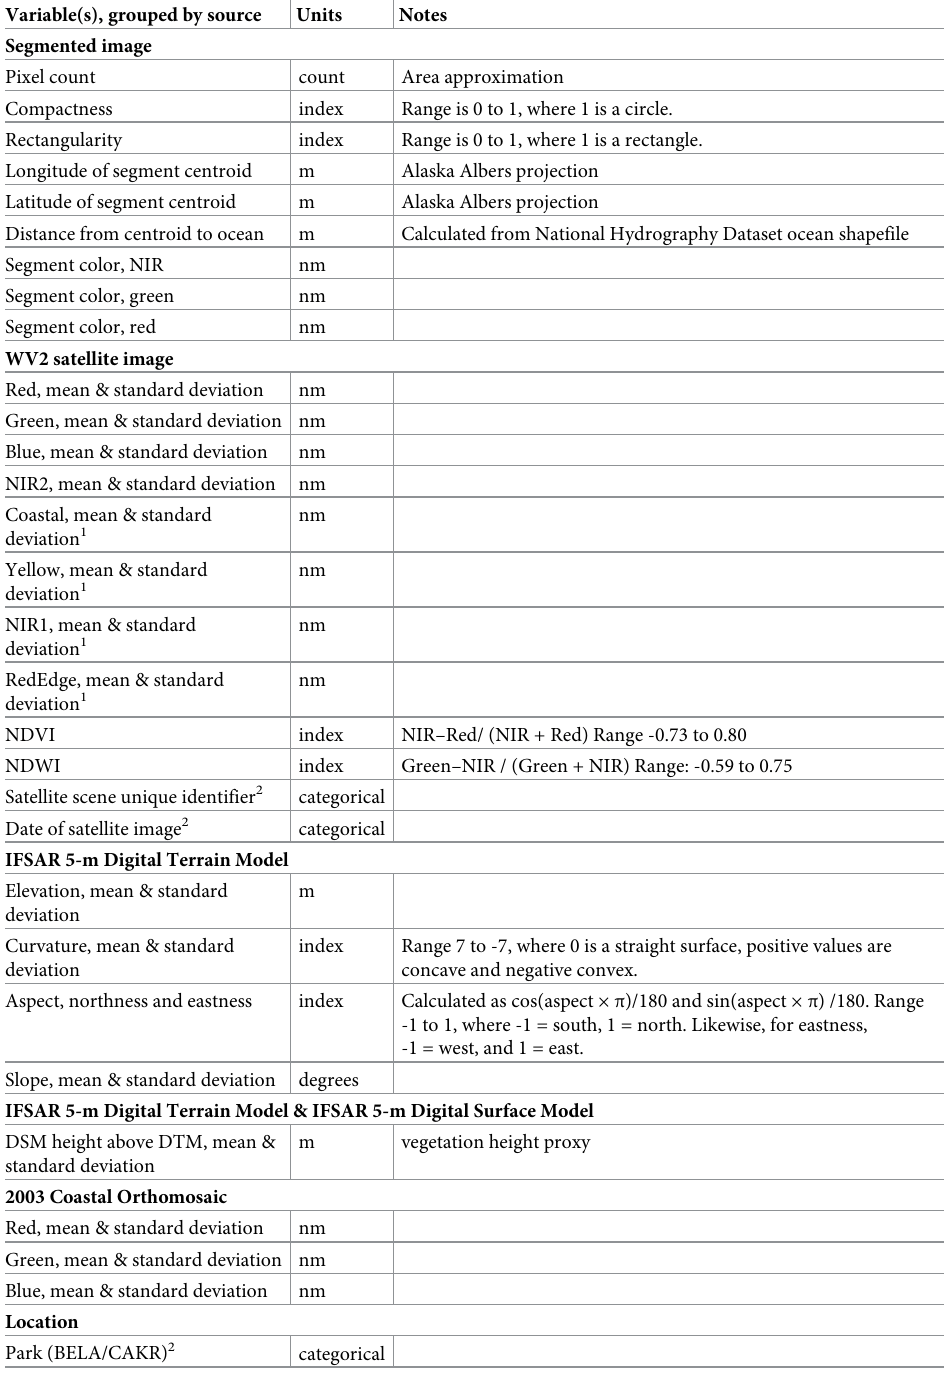
Table 3. Segment variables and their imagery